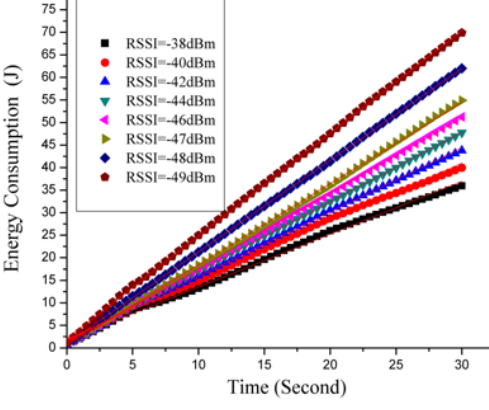
Figure 4. Energy consumed along